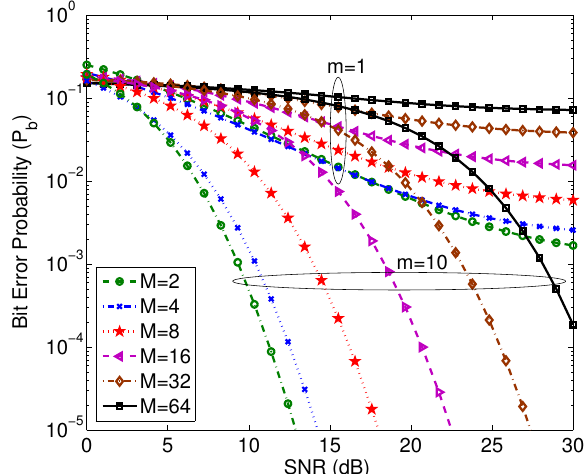
Figure 6. OFDM–MDPSK system with N = 64, T g = 400 ns and different M-ary